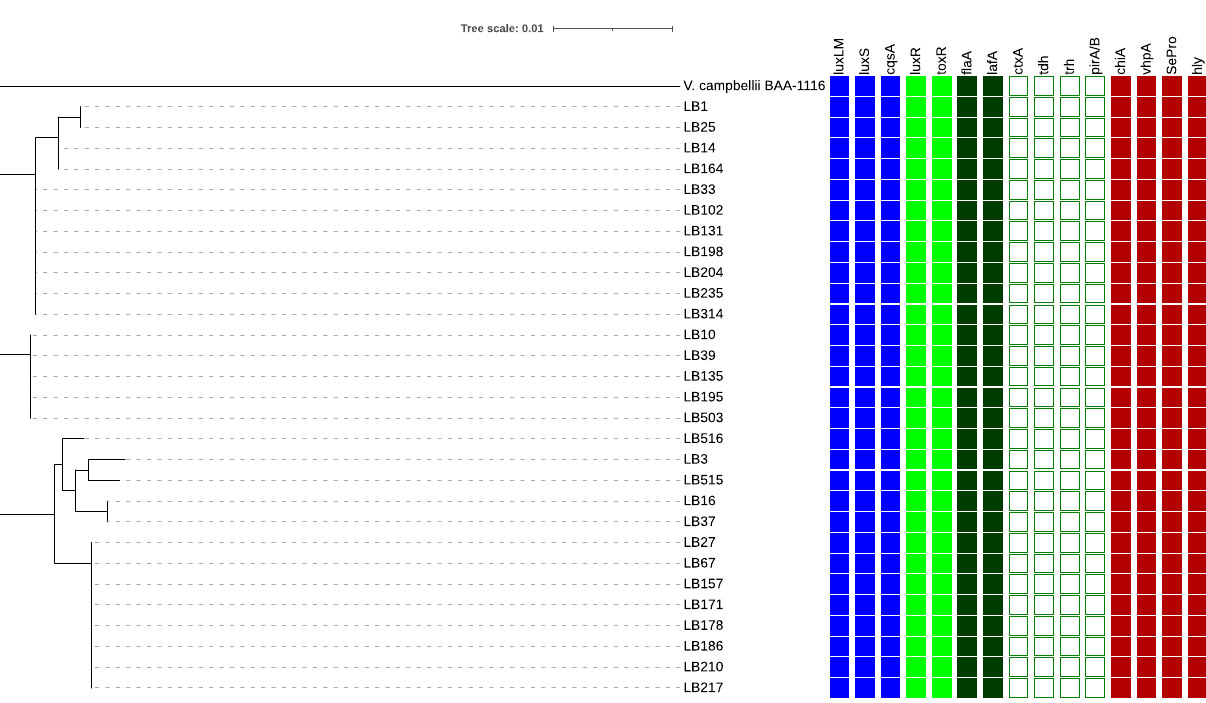
Figure 4. Distribution of virulence markers in Vibrio campbellii isolates based on gene-specific PCR. The phylogenetic tree was constructed based on toxR gene using maximum likelihood algorithm. The presence and absence of virulence markers was depicted by applying an additional panel using iTOL v4 (Interactive Tree of Life). The blue, red, green, and black shaded mark represents presence, while the white square box represents the absence of the